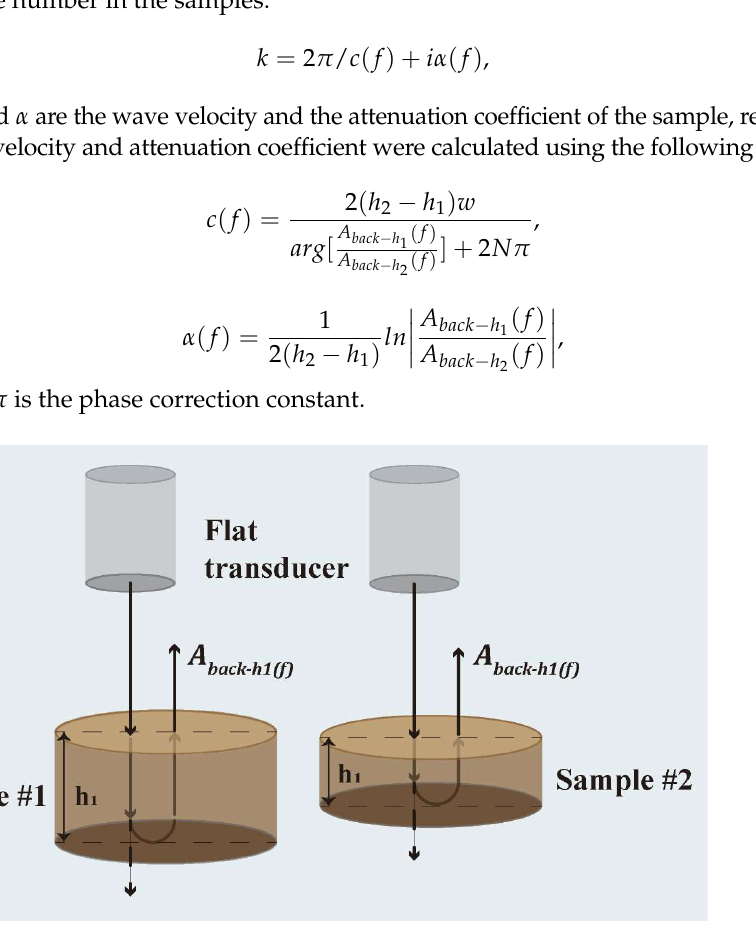
Figure 1. Schematic of an ultrasonic pulse-cho test.